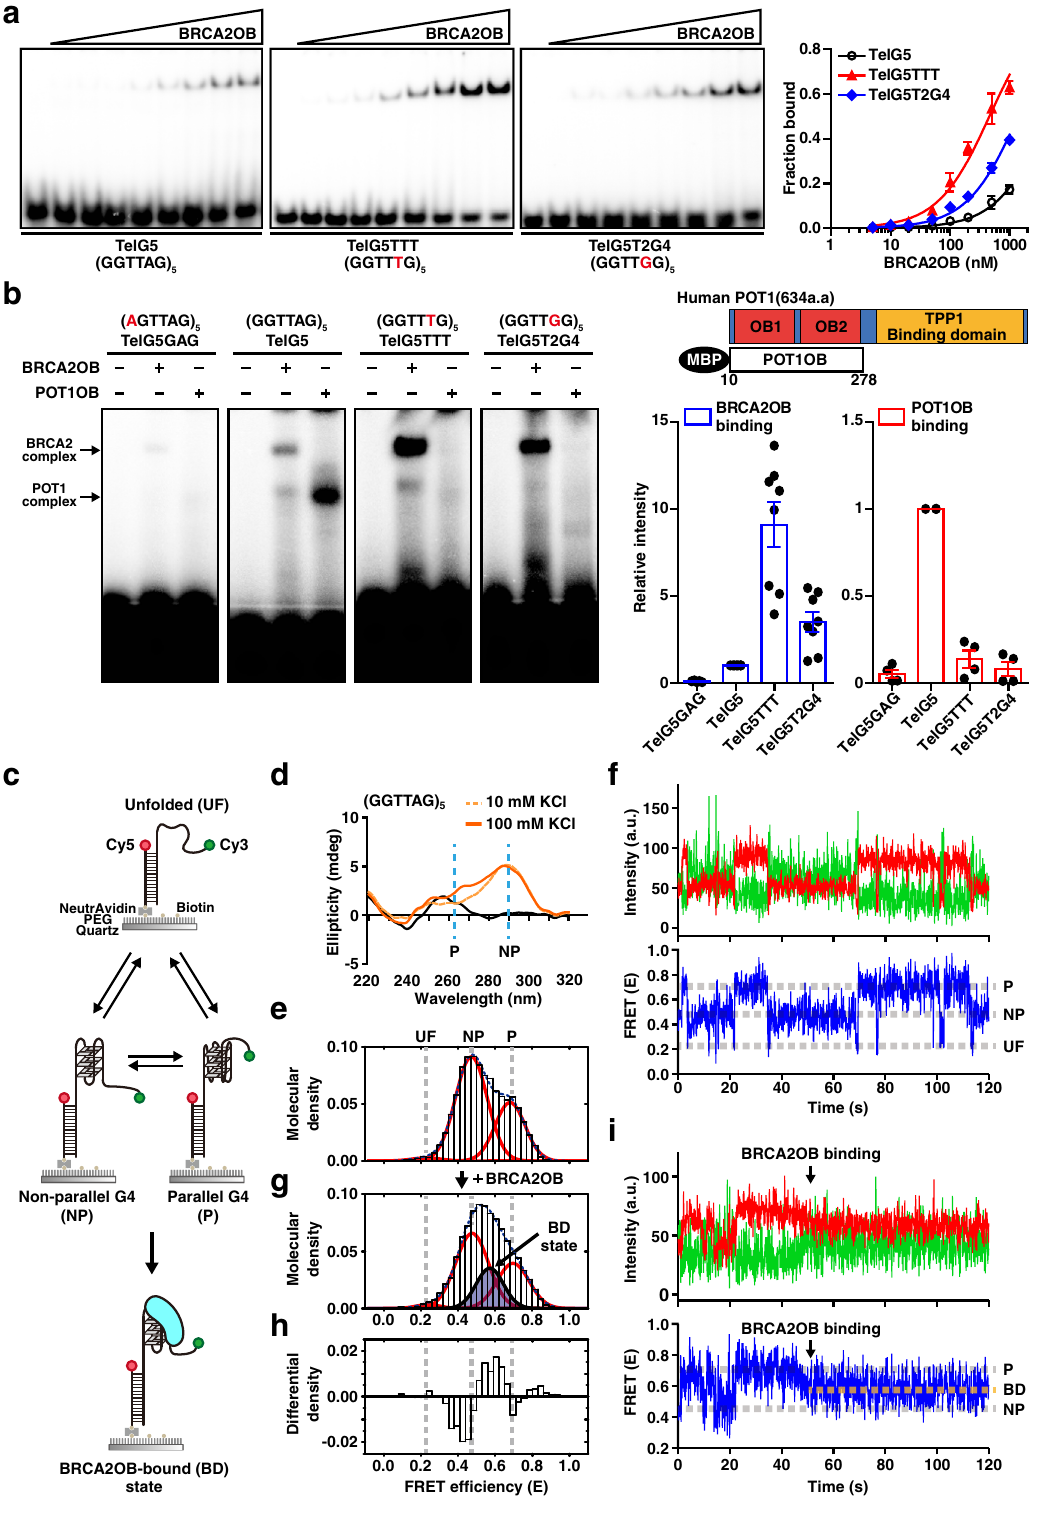
and TelG5. In comparison, BD fraction increased in TelG5TTT and TelG5TT when 100 nM (Fig. 3b) and 1 μ M of BRCA2OB (Supplementary Fig. 7c) were added. To quantify the BRCA2OB binding propensity of the four variants, EMSA was performed.